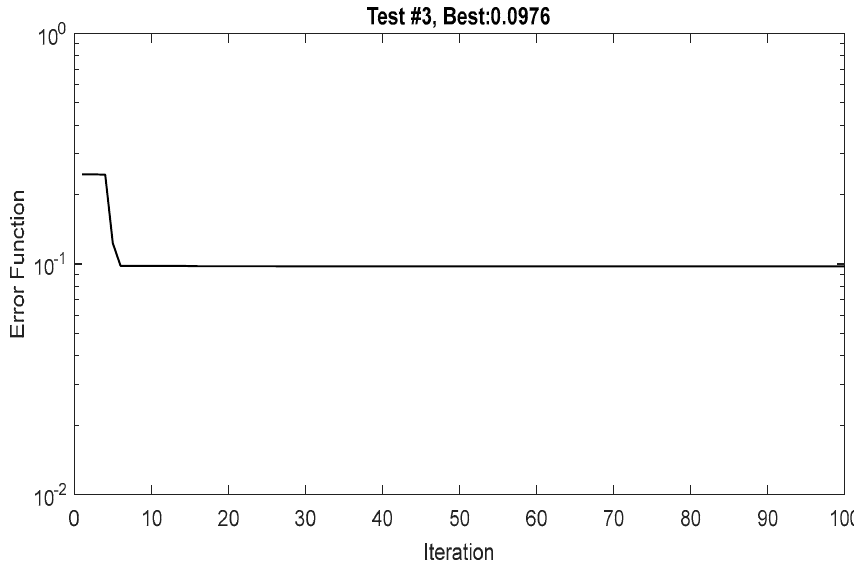
Figure 14. Variation in the error function at each iteration of the Genetic Algorithm in test #3.